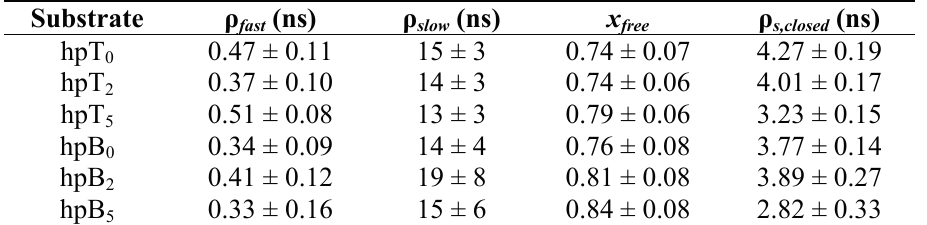
Table 3. Rotational correlation times, relative amplitudes of fast rotational correlation times and the steady state rotational correlation times in the closed hairpin conformation of the